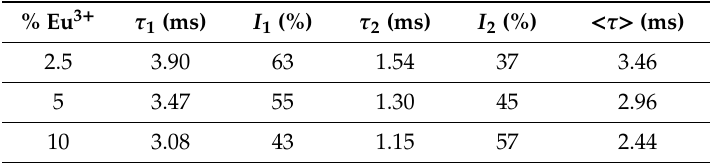
Table 1. Lifetime values for the Eu 3+ :(H 3 O)Lu 3 F 10 nanoparticles having different Eu 3+ contents for the